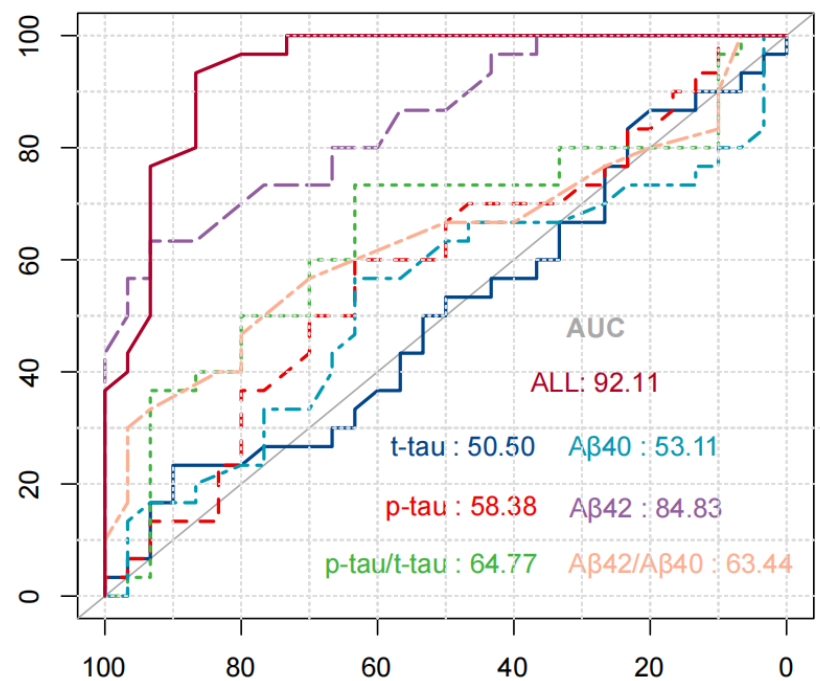
Figure 4. ROC curve of saliva components in the diagnosis of AD.